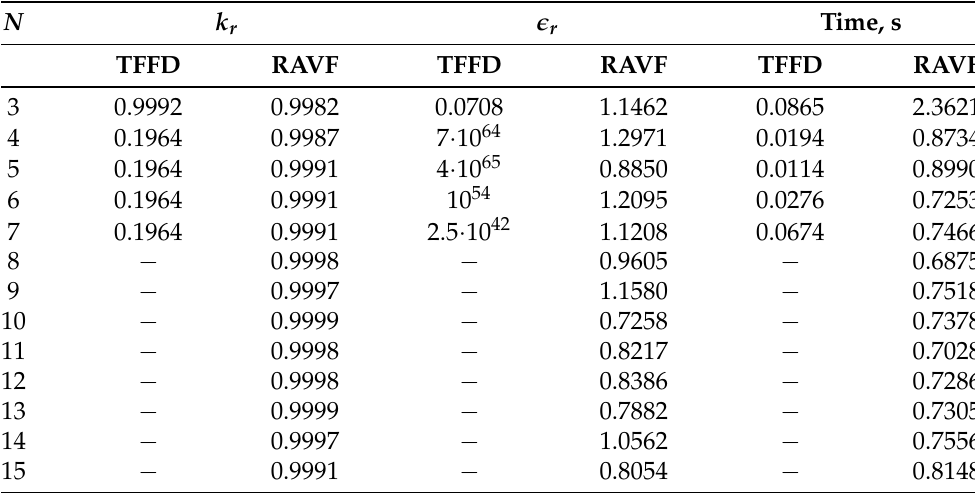
Table 4. Comparison of the two approaches for the buoy with a radius of 4 m for the different order of approximation N